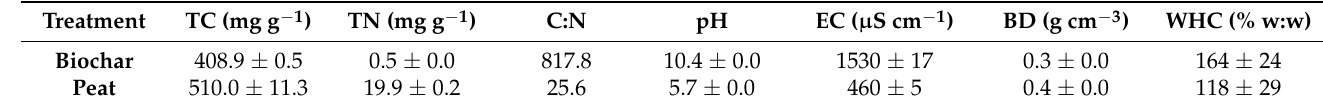
Table 1. Elemental composition (C and N), C:N ratios, pH, electrical conductivity (EC), bulk density (BD), and water holding capacity (WHC) represented as weight per weight of dry sample of the used biochar and peat substrates ( n = 3).